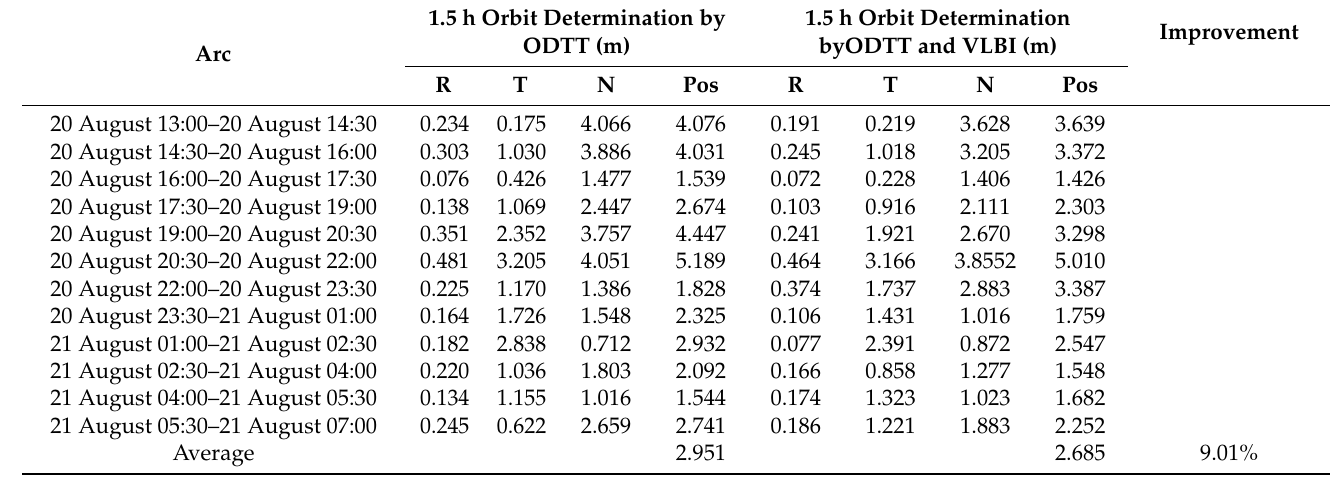
Table 5 shows results for an arc length of 1.5 h. Table 5. The results of the bias with arcs of 1.5